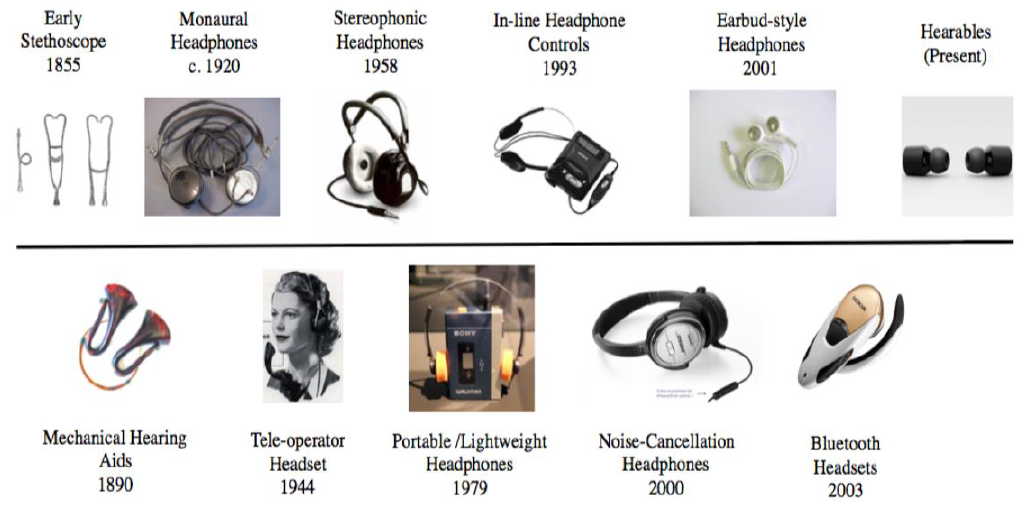
Figure 1. Evolutionary development of hearables.